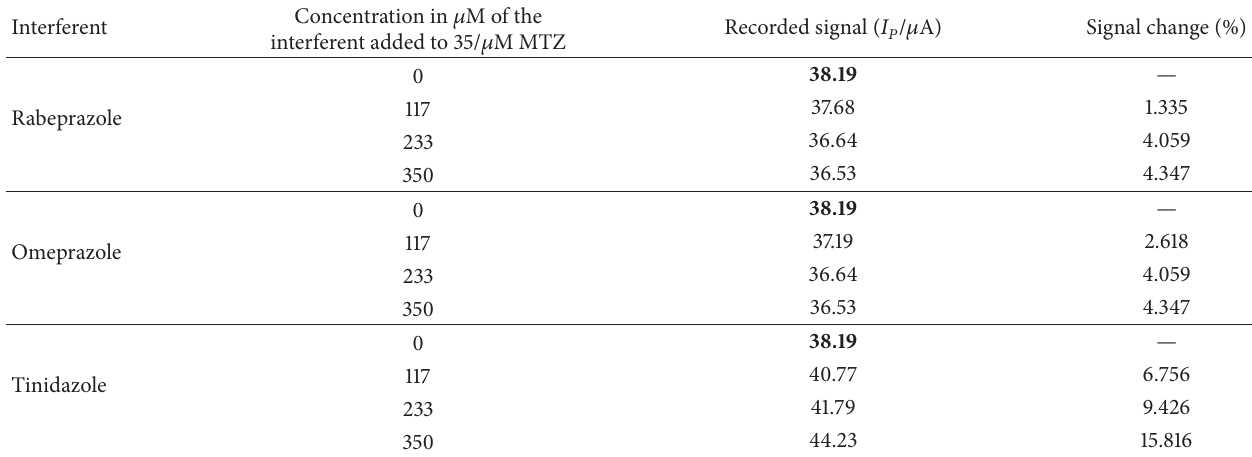
Table 3: Interference study of MTZ with different concentrations of rabeprazole, omeprazole, and tinidazole. Concentration in 𝜇 M of Interferent